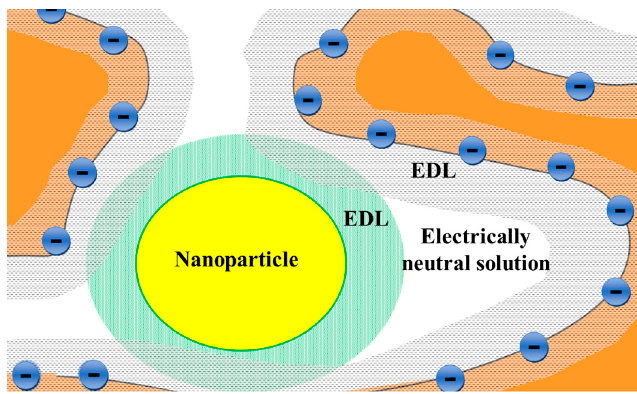
Figure 5. Schematic representation of a fragment of a mesoporous IEM containing a charged nanoparticle surrounded by an EDL. Adapted with permission from [174], Elsevier,